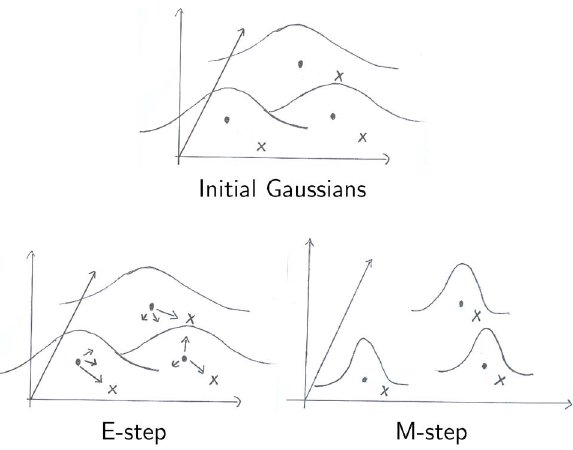
Figure 4. Illustration of the expectation maximization algorithm for a Gaussian mixture model. Dots represent the centroids of the Gaussians which are located at T ( y 1 , H ), ::: , T ( y M , H ) . Crosses represent the points in X . E-step: Arrows indicate values of the posterior for each point in Y . M-step: Steps towards convergence move the points closer and reduce the width of the Gaussians. Upon convergence, corresponding points should be close to each other and the Gaussian should be sharply